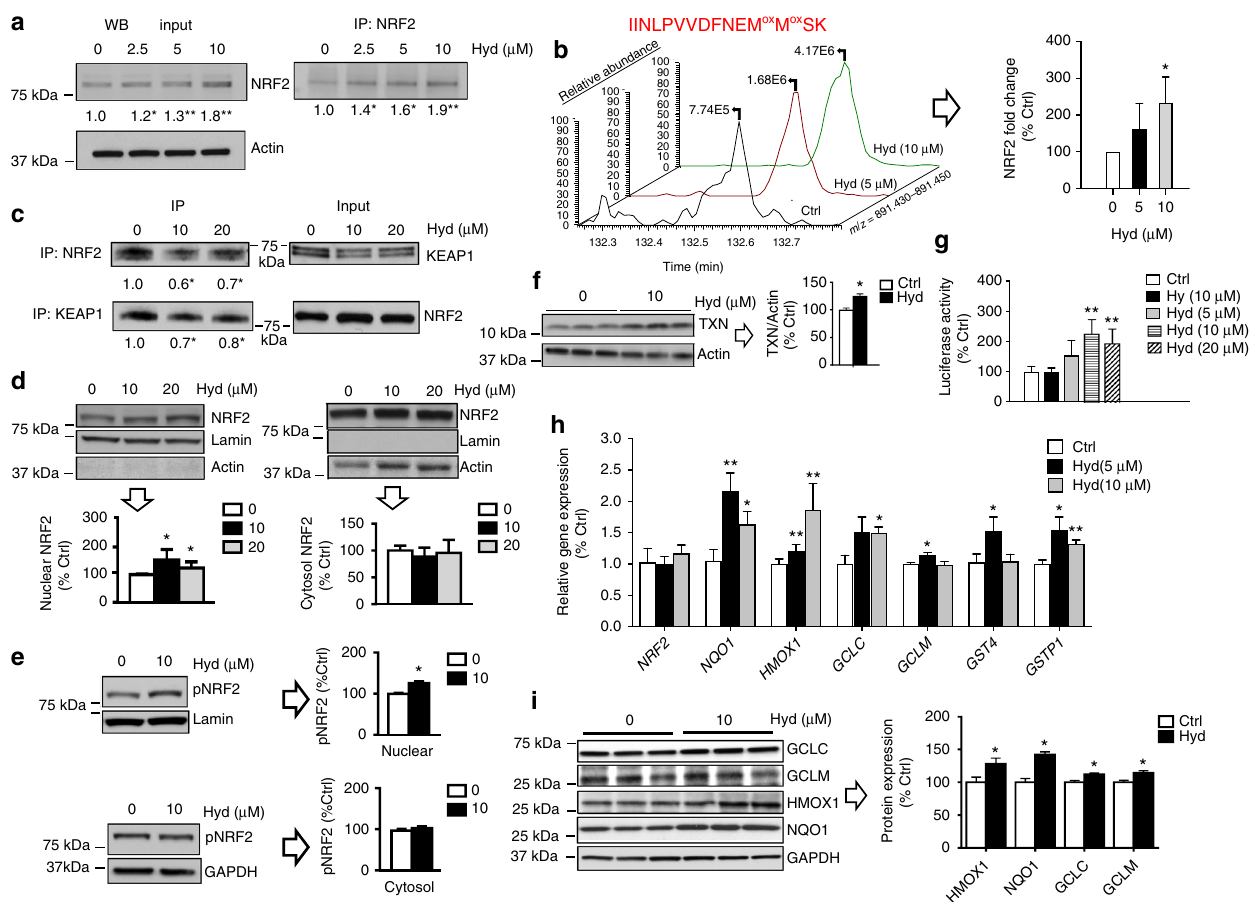
Fig. 3 Hydralazine enhances NRF2 signaling in SH-SY5Y cells. a Hydralazine increased cellular NRF2 protein in a dose-dependent manner demonstrated by western blot analysis of cell lysates (input) and NRF2 immunoprecipitates (IP:NRF2). * p < 0.05 and ** p < 0.01, two-tailed Student's t test, n = 3, mean ± SD. b The mass spectrometry based label-free quanti fi cation of NRF2 immunoprecipitates prepared in part A. Extracted ion chromatogram of a NRF2 peptide, IINLPVVDFNEM ox M ox SK, as well as bar plot quanti fi cation are shown. Samples were treated with 0.05% H 2 O 2 prior to mass spectrometric analysis. * p < 0.05, two-tailed Student's t test, n = 3, mean ± SD. c Hydralazine reduced the interaction between NRF2 and KEAP1. Interactions were measured by reciprocal Co-IPs followed by western blot analysis. * p < 0.05, two-tailed Student's t test, n = 3, mean ± SD. d NRF2 translocates to the nucleus with hydralazine treatment. Treated cells were subjected to cell fractionation and western blot analysis. * p < 0.05 and ** p < 0.01, two-tailed Student's t test, n = 3, mean ± SD. e Hydralazine treatment increased nuclear NRF2 phosphorylation quanti fi ed using an antibody speci fi c to NRF2 phosphorylation at serine 40. * p < 0.05 and ** p < 0.01, two-tailed Student's t test, n = 3, mean ± SD. f TXN, a potent regulator of the NRF2 – KEAP1 response system, is upregulated with hydralazine treatment. * p < 0.05, two-tailed Student's t test, n = 3, mean ± SD. g ARE-driven luciferase activity was increased with hydralazine treatment, indicating an increase in the transcriptional activation of NRF2 target genes. Hydrazine did not increase luciferase activity. ** p < 0.01, two-tailed Student's t test, n = 6, mean ± SD. h Hydralazine treatment increased the expression of NRF2 downstream targets measured by qPCR using actin as internal control. For the list of primers used for qPCR, see Supplementary Table 1 online. * p < 0.05, and ** p < 0.01, two-tailed Student's t test, n = 6, mean ± SEM. i Hydralazine treatment increased the expression of NRF2 downstream target measured by western blot analysis. * p < 0.05, two-tailed Student's t test, n = 3, mean ±